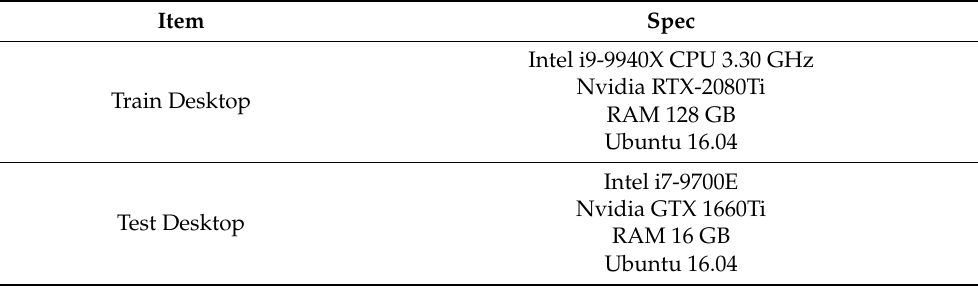
Table 3. Software configuration.